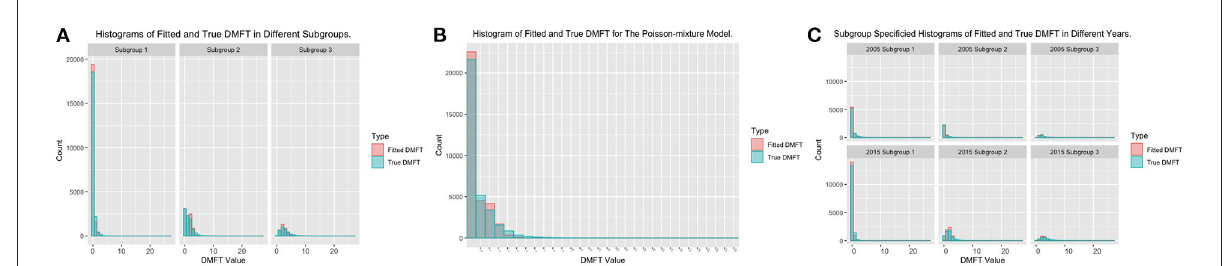
FIGURE2 Histograms of model fitting results of the Poisson mixture regression model. (A) Histograms of fitted and observed DMFT in different regions. (B) Histograms of fitted and observed DMFT for the Poisson mixture regression model. (C) Subgroup specified histograms of fitted and observed DMFT in different